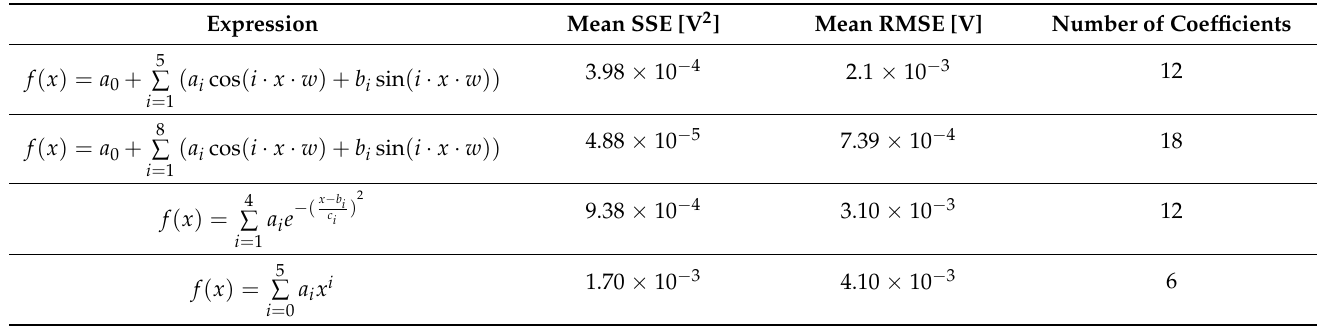
Table 2. Functions f ( x ) selected to fit the discharge voltage curve, with their representation errors and number of coeffi- cients